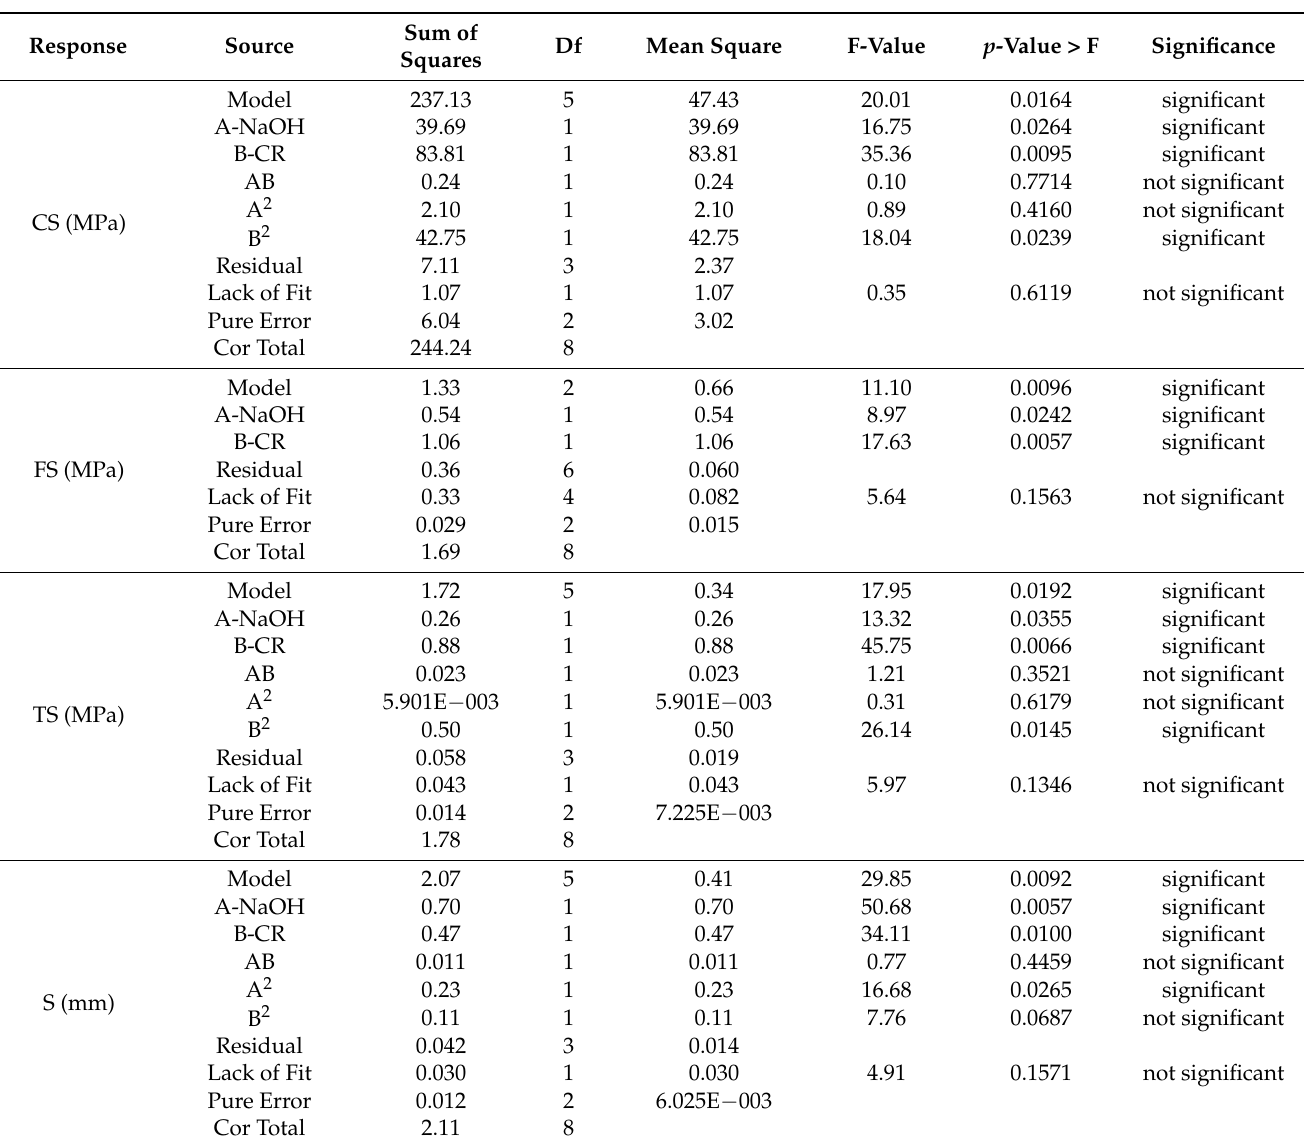
Table 3. Result of analysis of variance (ANOVA).